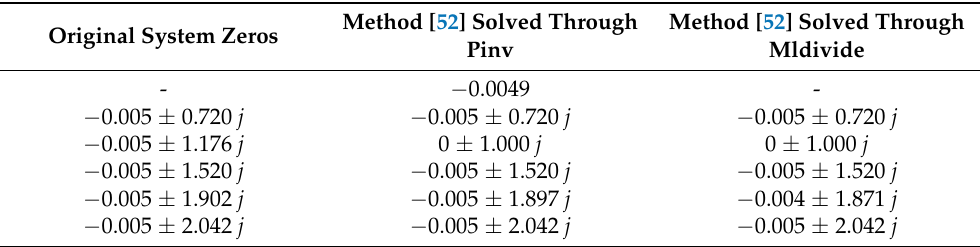
Table 6. Zeros of the original and modified receptance h 3,3 (j ω ) with the controller with integral action to assign a complex conjugate zero pair.